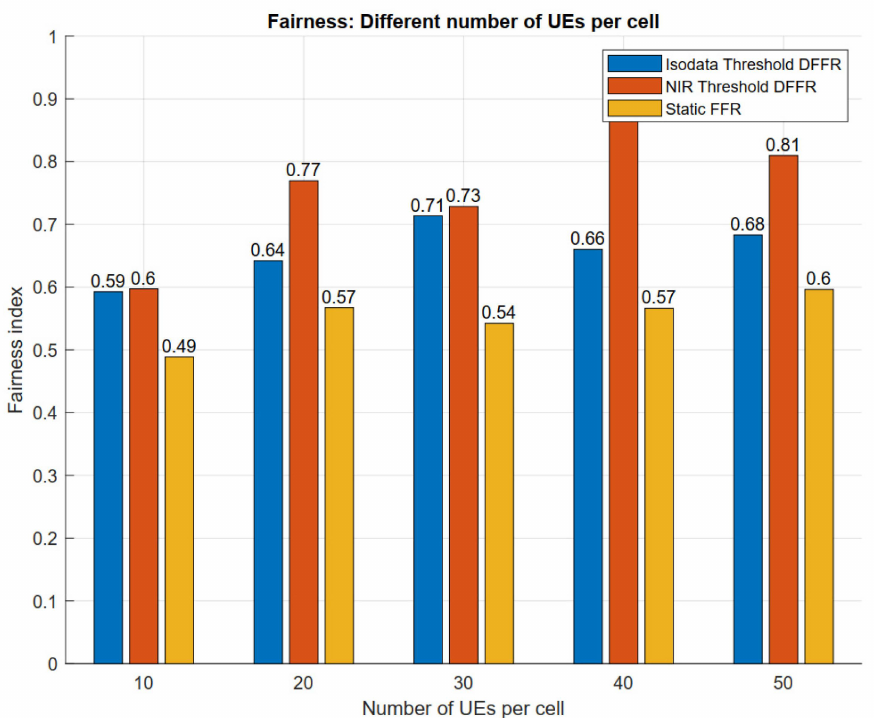
Figure 14. FFR configurations fairness chart for different number of user equipment per